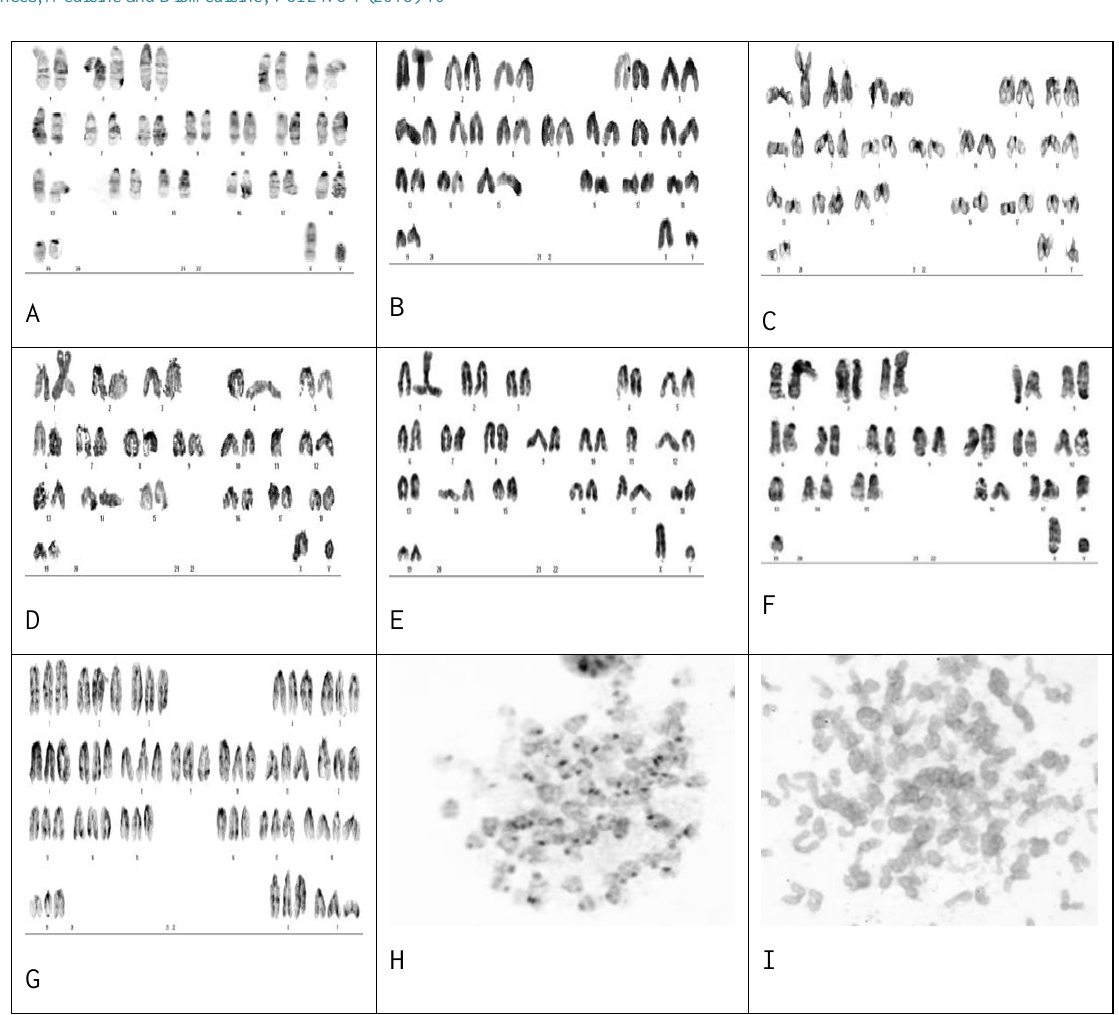
Figure 6 : The spread of chromosome metaphase and arrangement of chromosomes (1-19 pairs and XY) in the karyotyping software. Images representing structural and numerical abnormalities of the chromosome following HQ and etoposide exposure for 24 h. Each metaphase is analyzed using Applied Spectral Imaging System. The chromosome analyzed based on Adler ideogram. A: Control - Karyotype:40,XY, B: 1.5625µM HQ –Karyotype:39,XY,Rb(1.11), C: 3.125µM HQ - Karyotype:39,XY, Rb(1.11), D: 6.25µM HQ - Karyotype:39,XY, Rb(1.11), E: 0.05µM Etoposide-Karyotype :39,XY,Rb(1.11) F: 0.05µM Etoposide- Karyotype:37,XY,Rb(1.13)Rb(3.18),-19,-20, G: 1.5625µM HQ - hyperdiploidy karyotype, H: 6.25µM HQ -hyperdiploidy metaphase spread and I: Etoposide - hyperdiploidy metaphase spread (Magnification: 100X). Rb: Robertsonian.